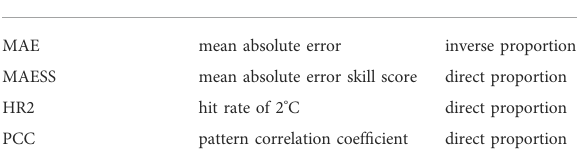
TABLE 2 The relationship between each evaluation metric and forecast